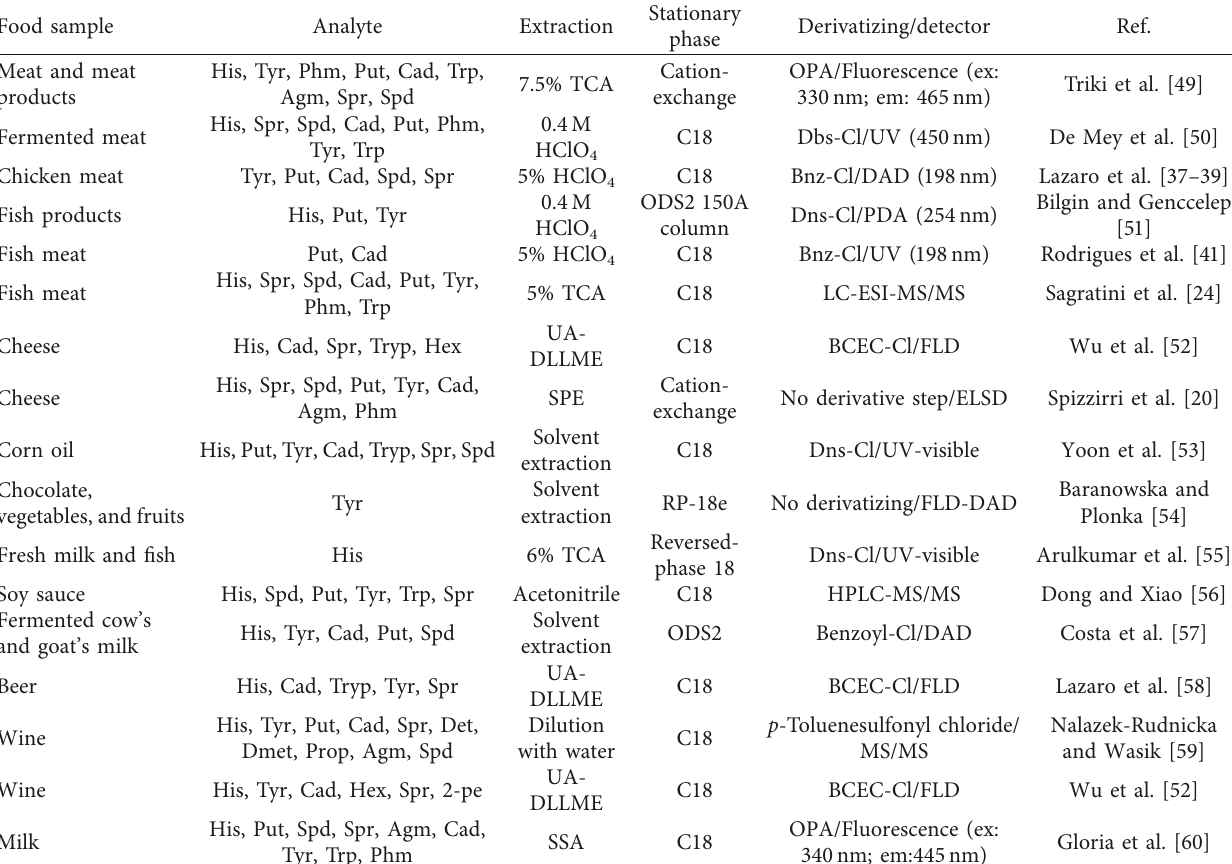
Table 2: Various studies based on HPLC techniques for biogenic amine detection in food and beverages. Food